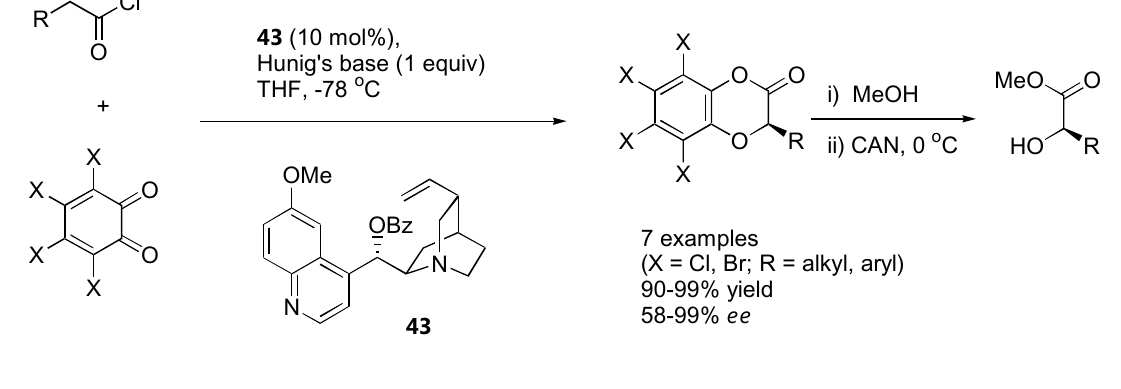
Figure 34. Organocatalyzed  -aryloxylation of carboxylic acid derivatives via ketene enolates